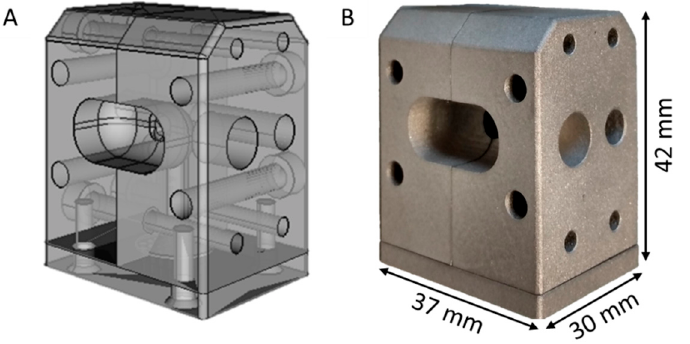
Figure 3. Individually designed spinneret ( A ) manufactured by metal 3D powder bed fusion printing (PBF) ( B ), consisting of the 90° deflection in split design with multifilament die plate for the melt extrusion of pharmaceutical fiber and yarn-like materials.